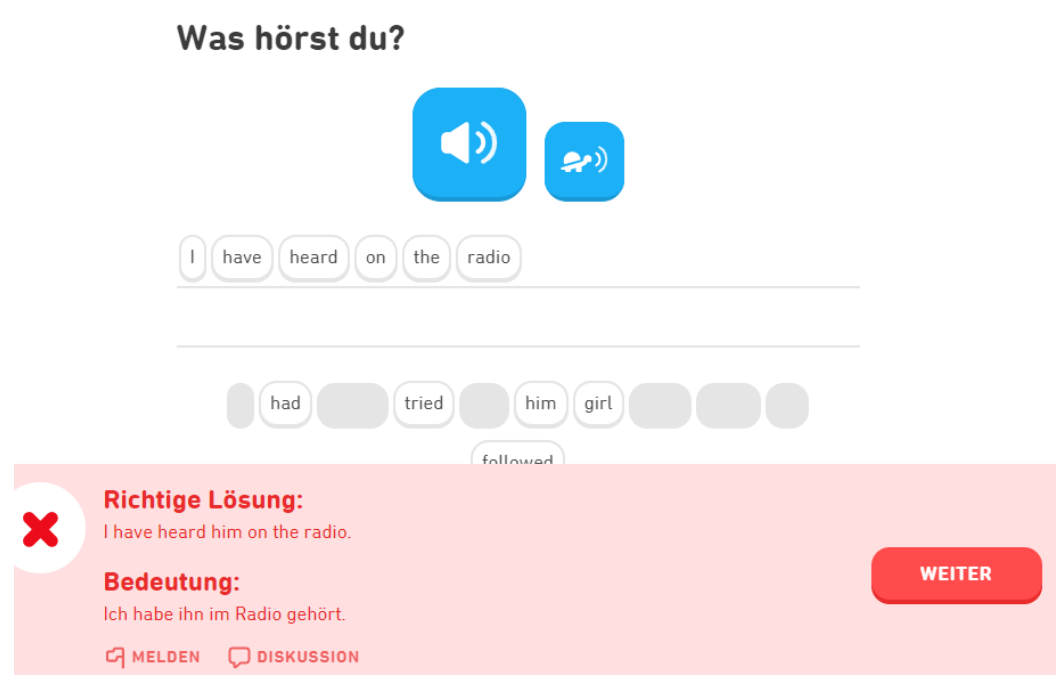
Figure 5: Reaction to an incorrect response when